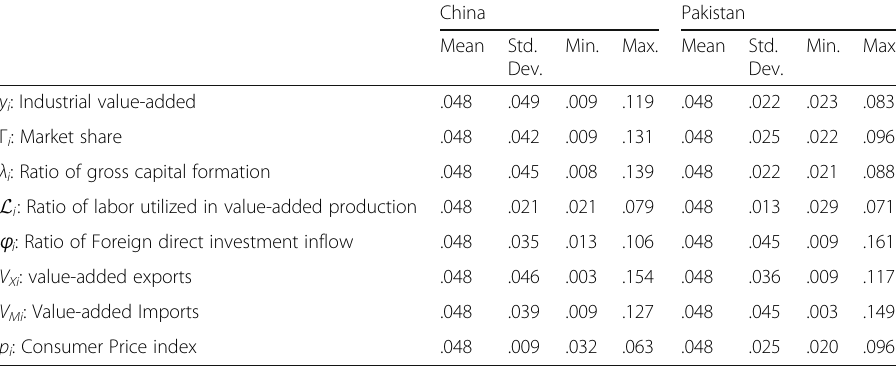
Table 1 Summary statistics of Key variables in China and